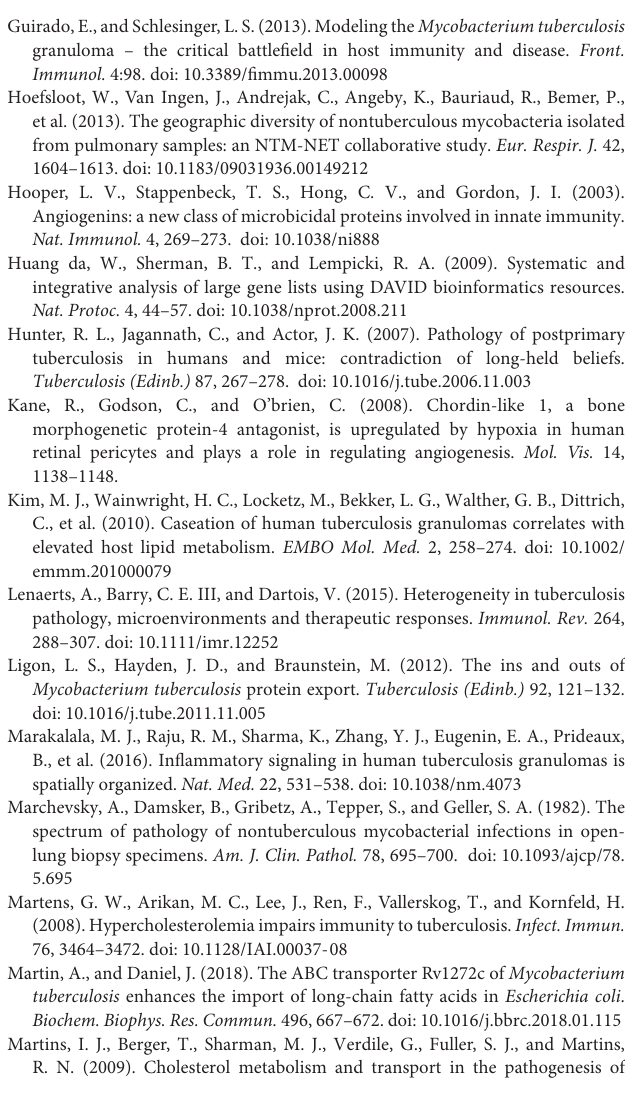
FIGURE S3 | Dendrogram of samples by hierarchical clustering analysis based on LFQ intensity values. Cluster dendrogram of samples in Figure 2D is shown. FIGURE S4 | Protein composition in TB granulomatous lesions. (A) Volcano plot of protein abundance between caseous and cellular regions of TB granulomatous lesions. Highlighting dots correspond to proteins with significantly different abundance (FDR < 0.05 and absolute value of fold change > 5). GO terms related to biological processes of abundant proteins in caseous (B) or cellular (C) regions of TB granulomatous lesions. Top 20 ranked GO terms are listed. The proportion of identified protein numbers related to indicated GO terms and FDR are also shown. FIGURE S5 | Identification of proteins with a different abundance between caseous and cellular regions of MAC-LD granulomatous lesions. Highlighting dots correspond to proteins with significantly different abundance (FDR < 0.05 and absolute value of fold change > 5). FIGURE S6 | Volcano plot showing one protein with different abundances between the caseous regions of TB and those of MAC-LD. FIGURE S7 | Proteins driving separation between caseous regions of TB and those of selected MAC-LD. Components constituting PC1 and PC2 in Figure 2C